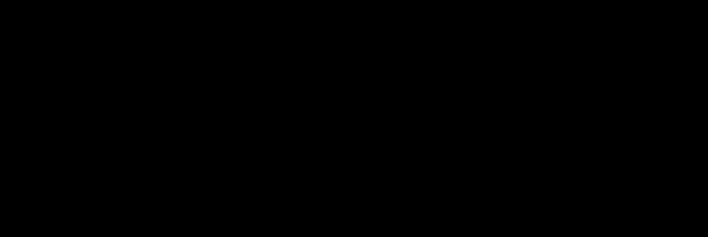
The effects of tannic acid (TA) on mitochondrial enzyme activities. Data represent mean ± SEM. Compared to the CONT group (##P < 0.01). Compared to the isoproterenol (ISO) group (*P < 0.05 and **P < 0.01).